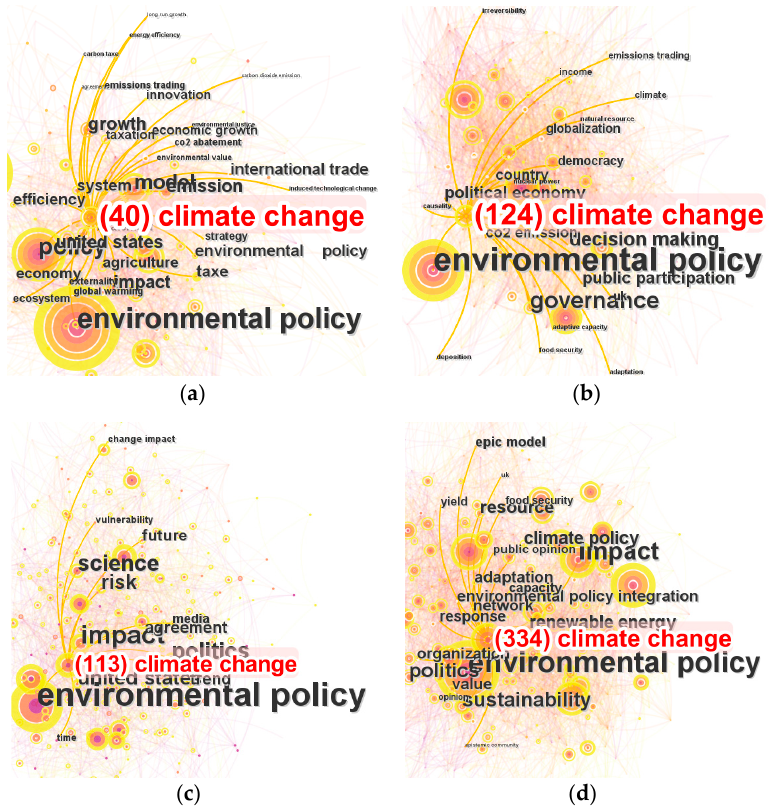
Figure 10. Topic network of related literature in each period. ( a ) Period I: Fusion, 2000–2005; ( b ) Period II: Governance, 2006–2011; ( c ) Period III: Assessment, 2012–2014; ( d ) Period IV: Deepen,